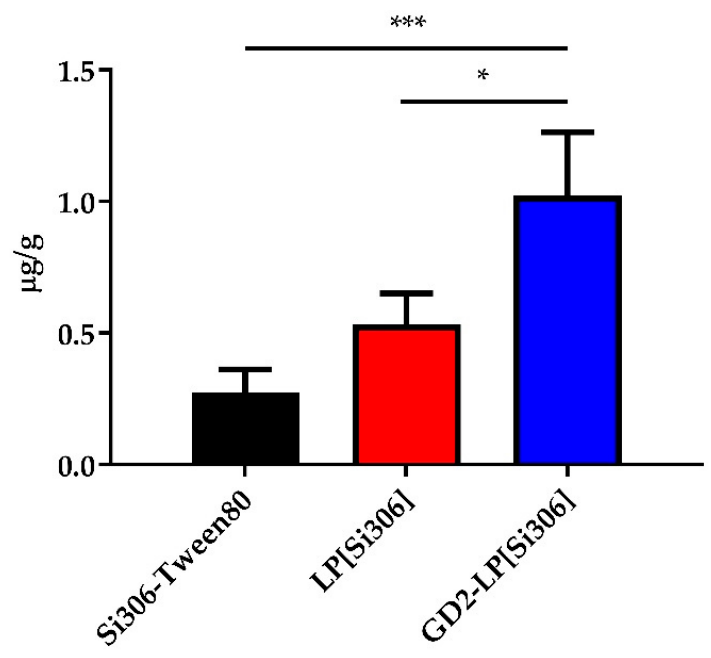
Figure 6. In vivo Si306 tumor uptake. IMR-32-bearing mice ( n = 3/group) were treated with 5 mg/kg Si306, either free (Si306-Tween80) or encapsulated into untargeted and GD2-targeted liposomes (LP[Si306] and GD2-LP[Si306], respectively). 24 h after treatments, mice were euthanized, tumors removed and processed as described in the Materials and Methods section. Columns: mean ± SD. * p < 0.05: GD2-LP[Si306] vs. LP[Si306]; *** p < 0.001: GD2-LP[Si306] vs.